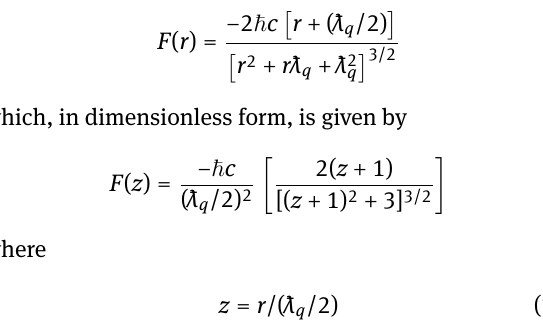
Figure 2: Comparison of measurements [1] and of the present RLM results: Measured [1] radial force and pressure distributions r 2 p ( r ) and p ( r ) , respectively, in the proton vs the radial distance r from the center of the proton (thick black line) and comparison with those computed here via the rotating lepton model, (RLM), (thick yellow line). Uncertainties in [1] shown in the Figure correspond to one standard deviation. Also shown is the geometry of the rotating lepton model used here to compute the force F ( r ) = 4 πr 2 p ( r ) , where F ( r )/4 π = r 2 p ( r ) , which is the quantity plotted in [1]. Thus the figure allows for direct comparison of the data of [1] (thick black line) with the present results (computed from equation (8), thick yellow line). The two distance scales (r of the present work and r